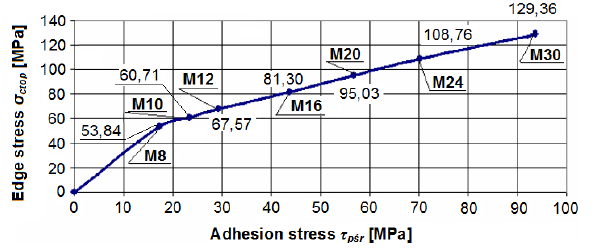
Figure 2: Dependency edge stress – adhesion stress for M8 ÷ M30 anchors in the gable wall.